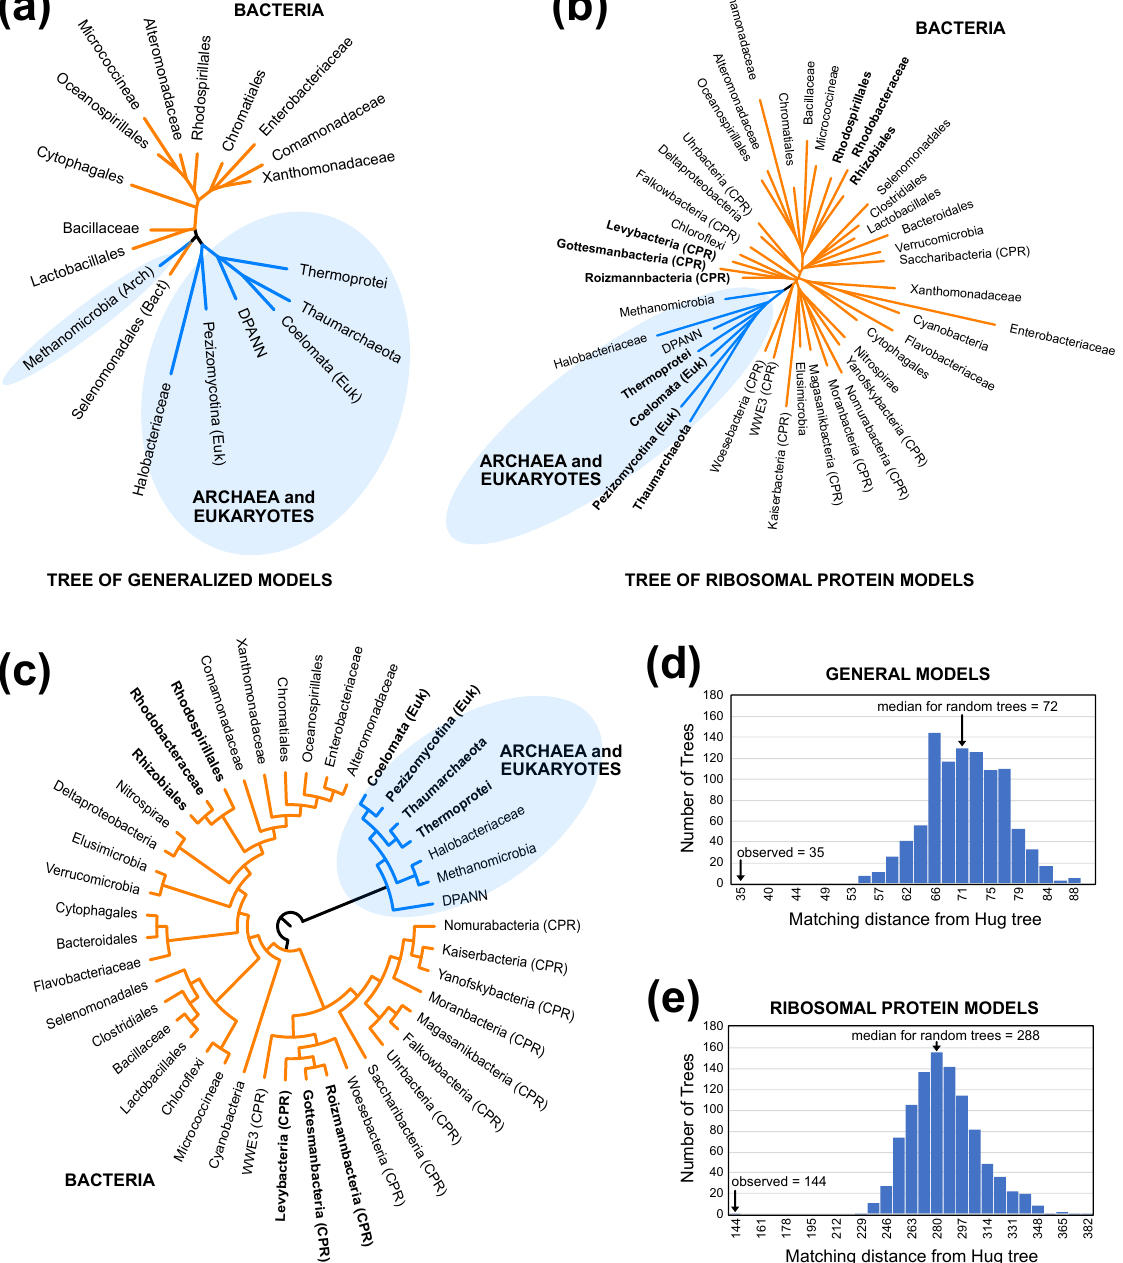
Matching distance from Hug tree